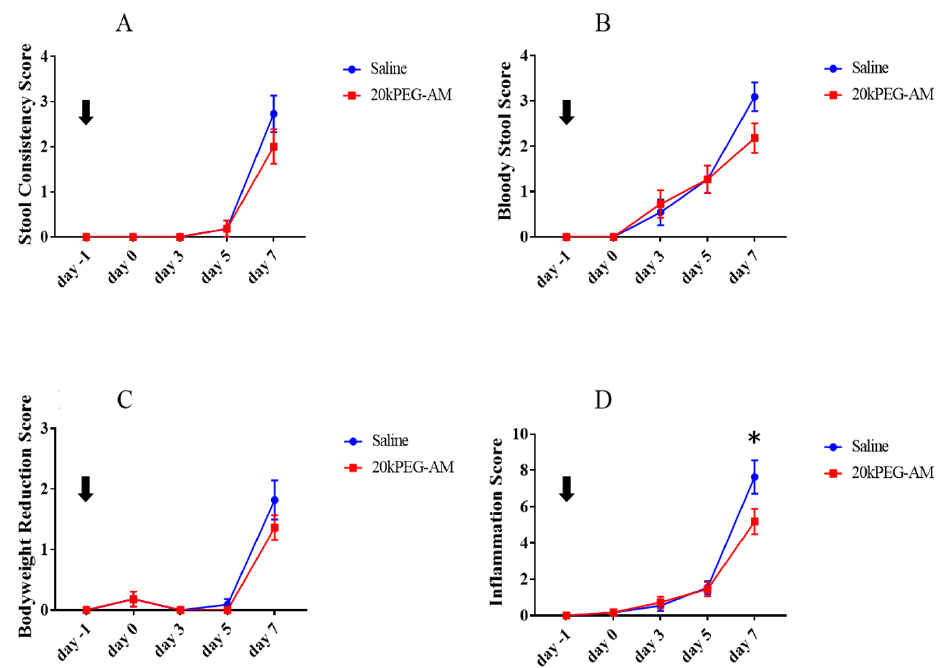
Figure 5. Comparison of scores in the DSS-induced colitis model following treatment with 20kPEG-AM (n = 11 mice/group). Single-injection protocol: ( A ) stool consistency score, ( B ) bloody stool score, ( C ) bodyweight reduction score, and ( D ) inflammation score. Results are shown as means ± S.E.M. * p < 0.001 versus control.